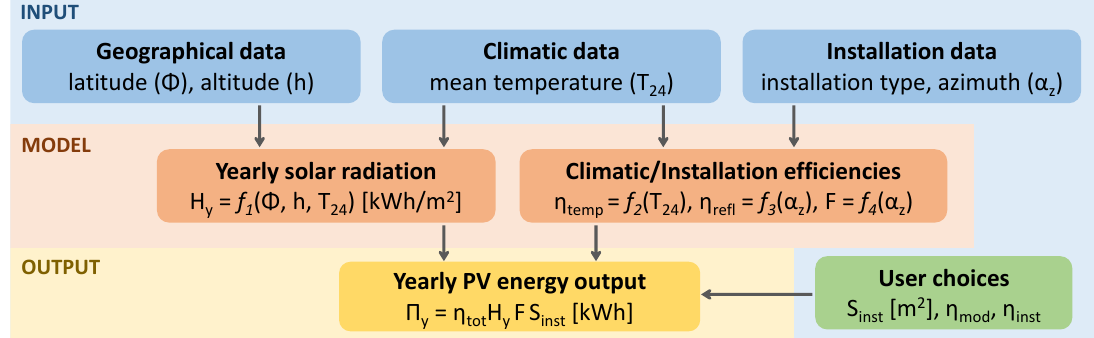
Figure 2. Overview of the proposed methodology for fast estimation of solar irradiation and photovoltaic energy potential over large territories.